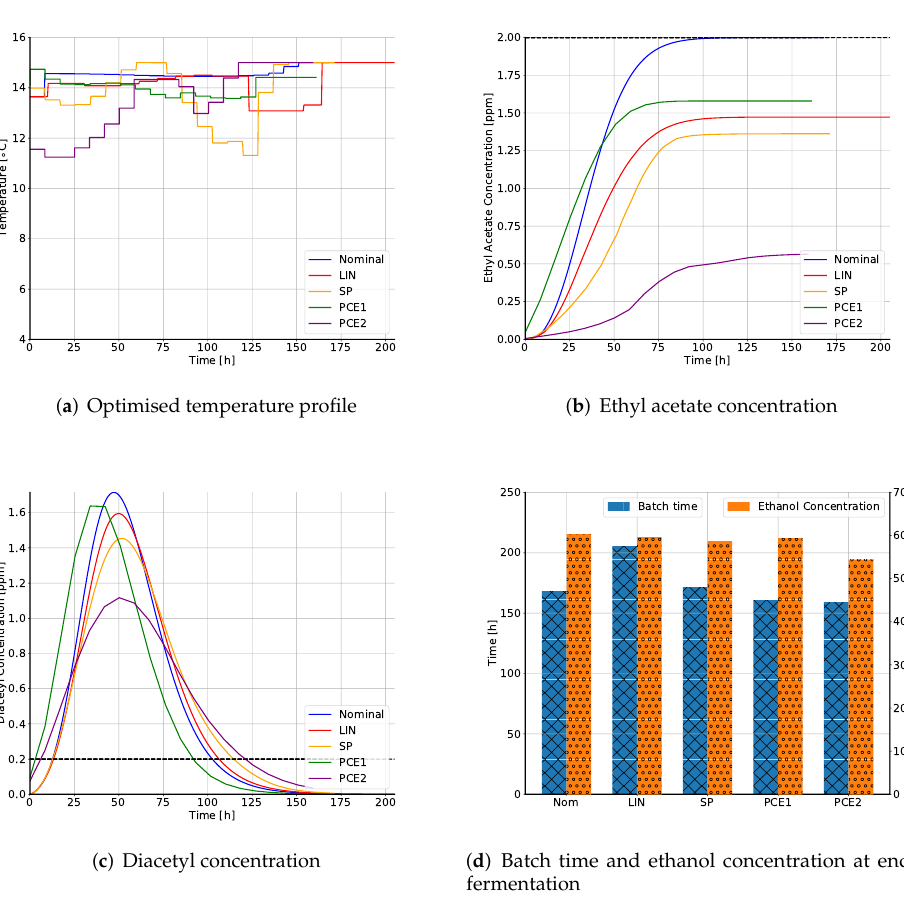
Figure 4. Optimisation results for maximising ethanol with all three methods and α = 1.65. The concentration trajectories depicted were obtained by applying the optimised temperature trajectory to the model with nominal parameters.